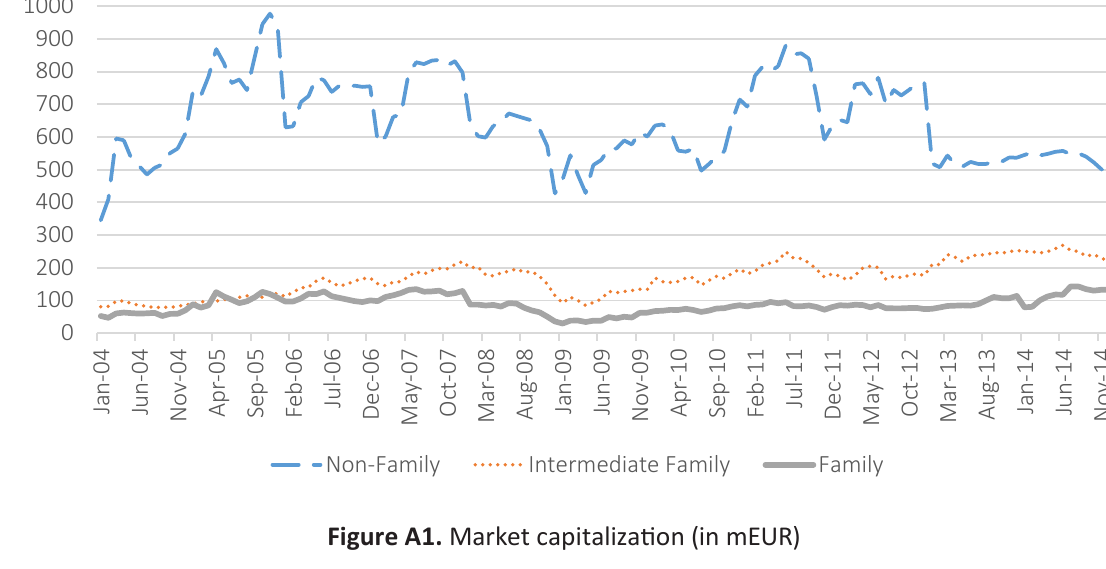
Figure A1. Market capitalization (in